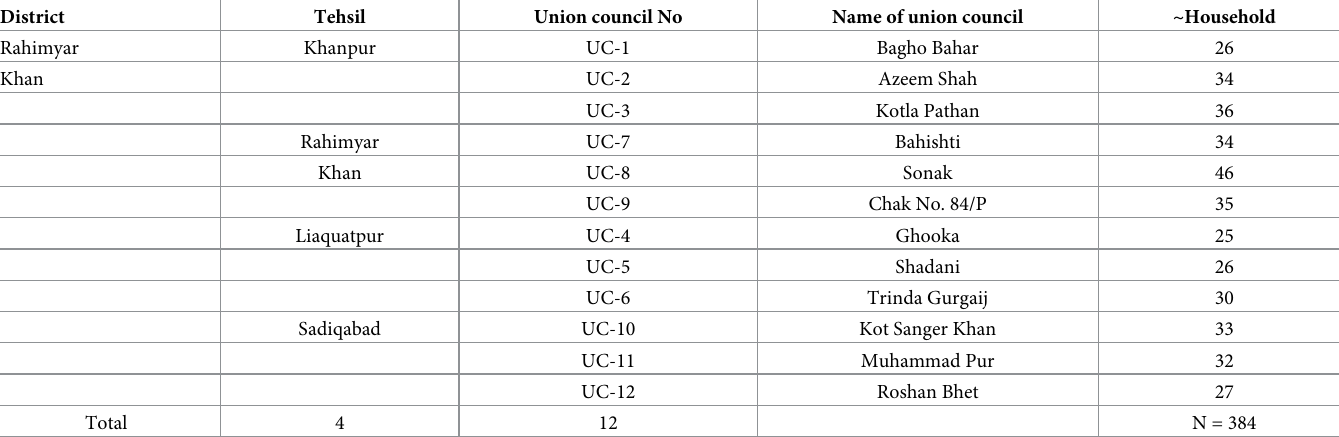
Table 1. Distribution of sample size from tehsils to union councils.